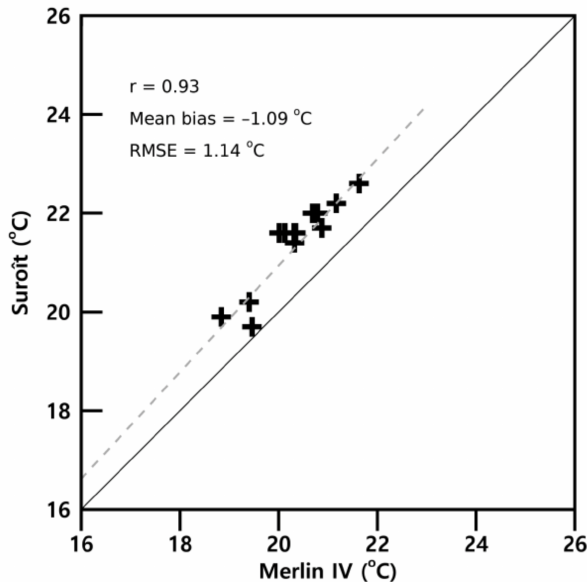
Figure 8. Comparison of SST between the aircraft and the ship.